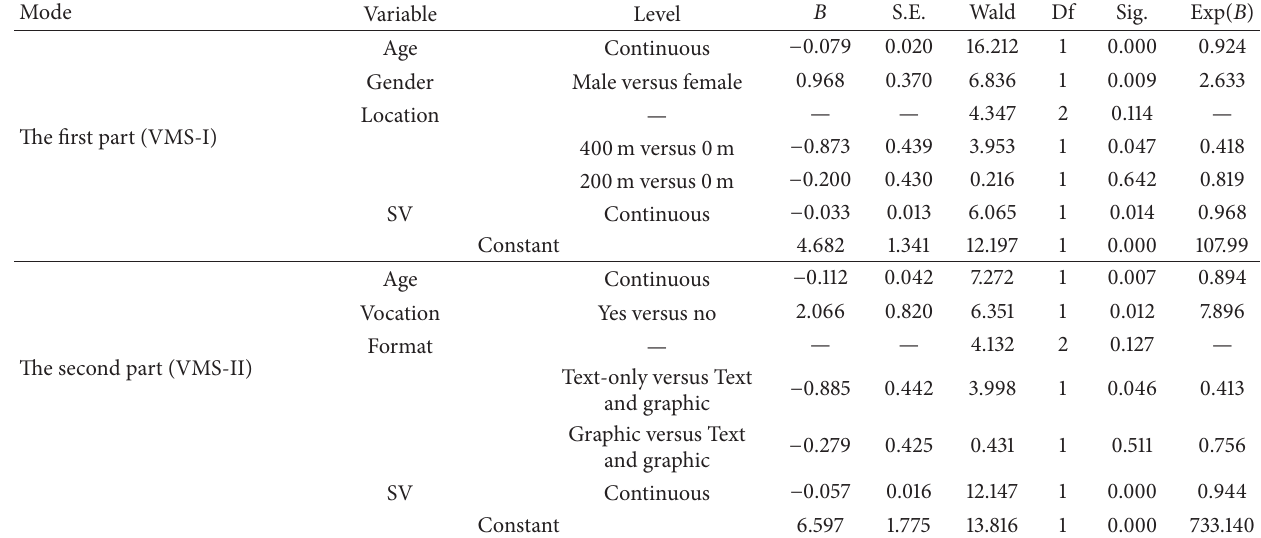
Table 3: Parameter estimates of logistic regression models for route choice.